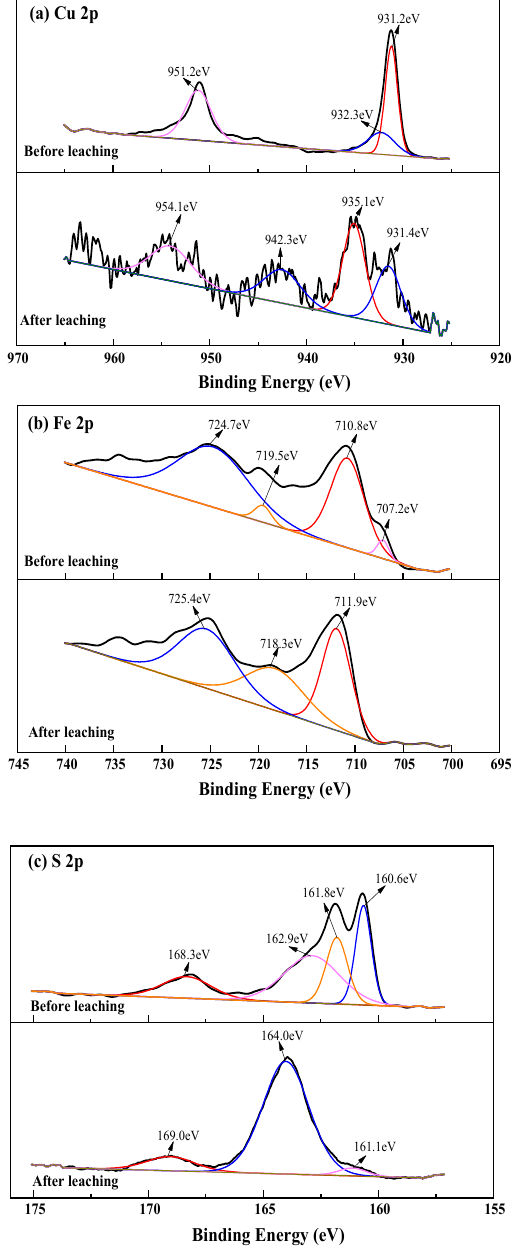
Figure 7. XPS spectra showing ( a ) Cu 2p, ( b ) Fe 2p and ( c ) S 2p peaks from the surface of specimens collected from unleached chalcopyrite and leached